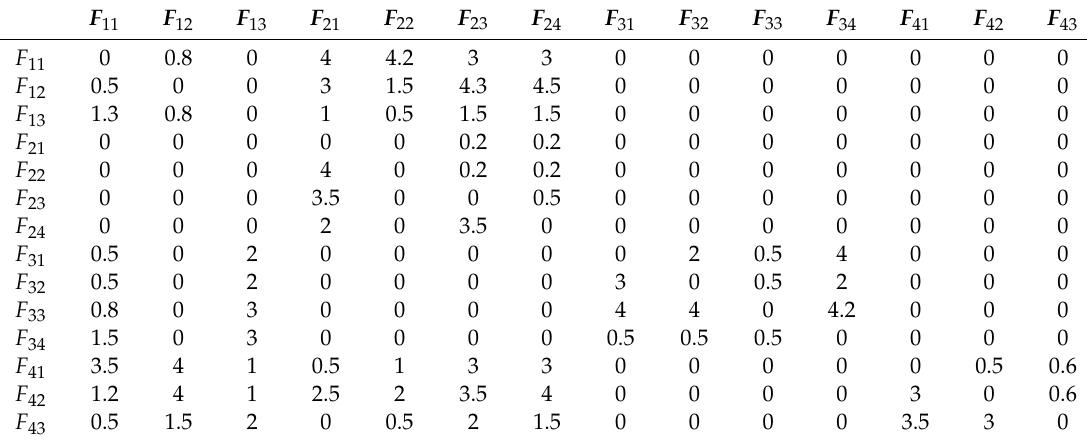
Table 3. The results of the matrix M 1.